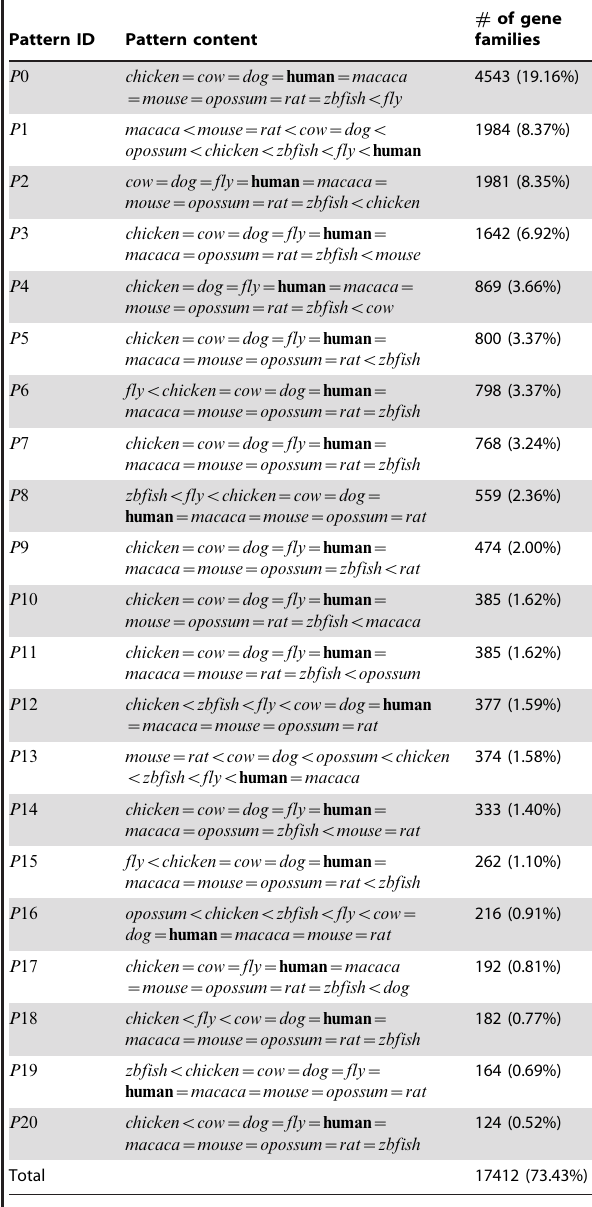
Table 2. The first 21 major